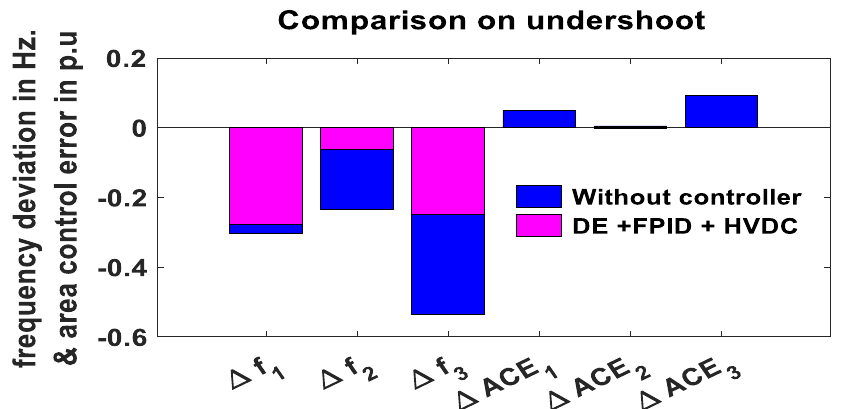
Figure 16. Comparison of controller and without controller for settling time for frequency deviation and area control error.